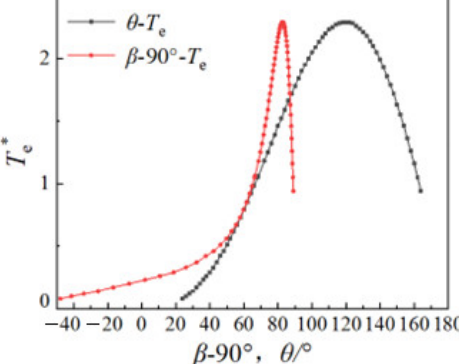
Figure 16. The curve of per unit value of torque at λ = 0.8.